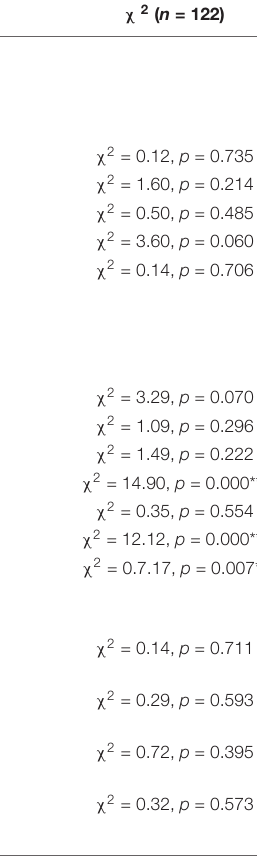
TABLE 3 | The language and additional needs of children with DLD according to kindergarten teachers and primary school teachers.